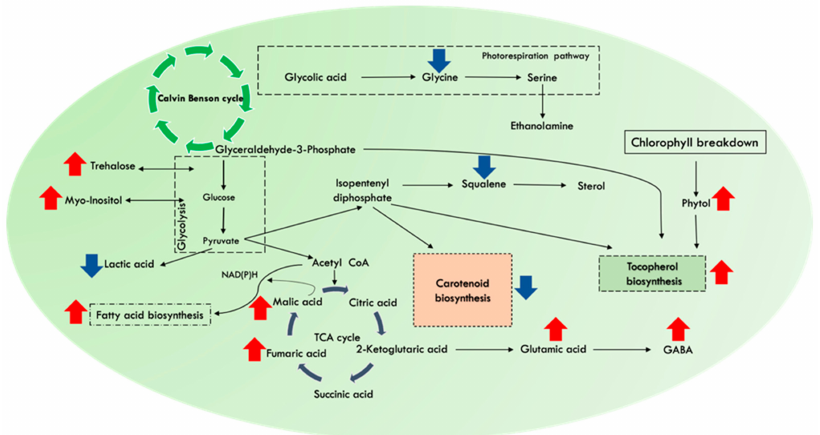
Figure 6. Schematic representation of essential pathways and their metabolites involved in the multi-fold enhancement of tocopherol yields in the native isolate Monoraphidium sp. CABeR41 sub- jected to effect of high CO 2 supplementation and nitrate limitation (NL HC ) condition. Upregulation represented in the red colour ( ↑ ); downregulation represented in the blue colour ( ↓